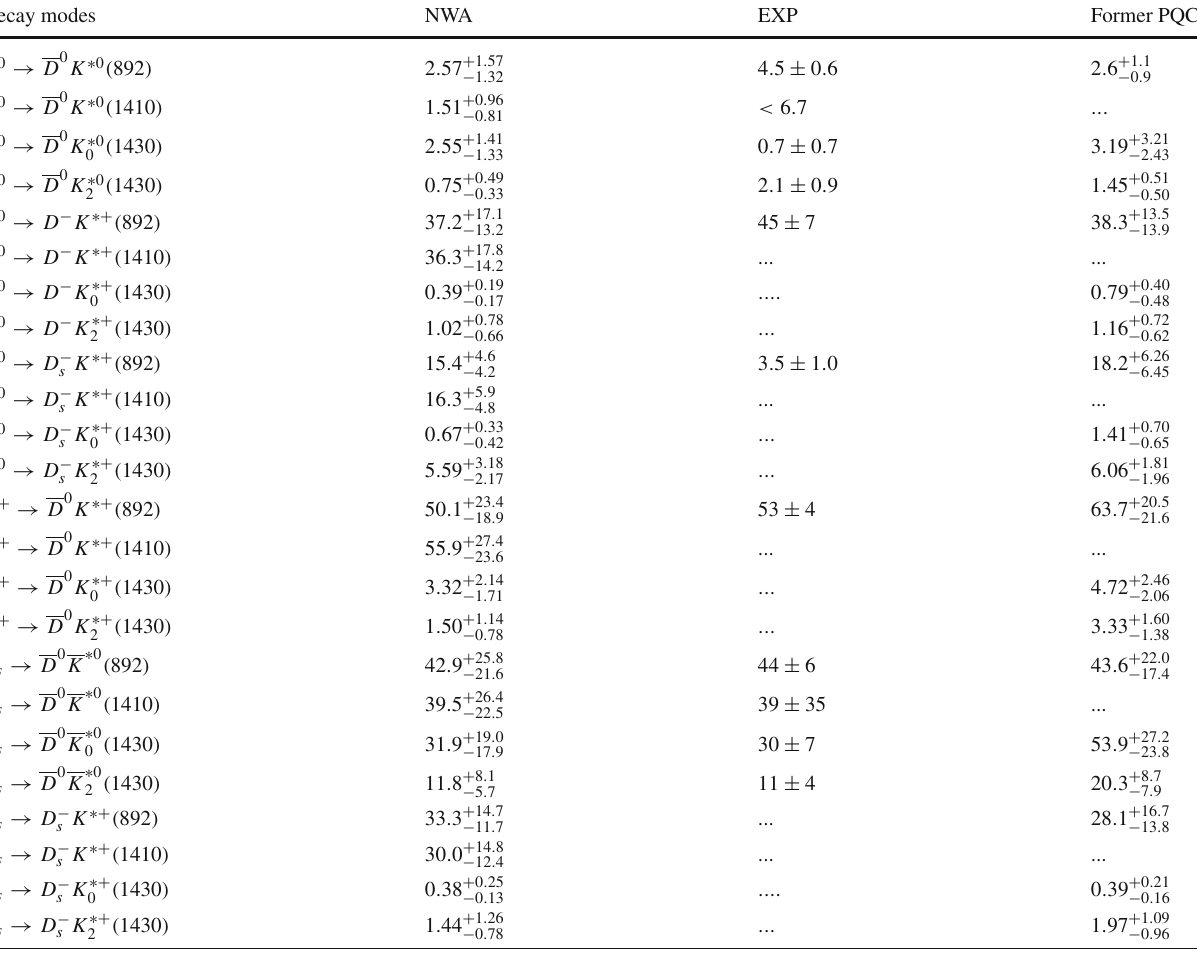
Table 2 The branching ratios (in 10 − 5 ) of B ( s ) → DK ∗ decays probed from the quasi-two-body B ( s ) → D ( K ∗ → ) K π decays based on the narrow-width-approximation(NWA), together with the experimental data [85] and the former PQCD predictions from Refs. [59,61,64] Decay modes NWA EXP Former